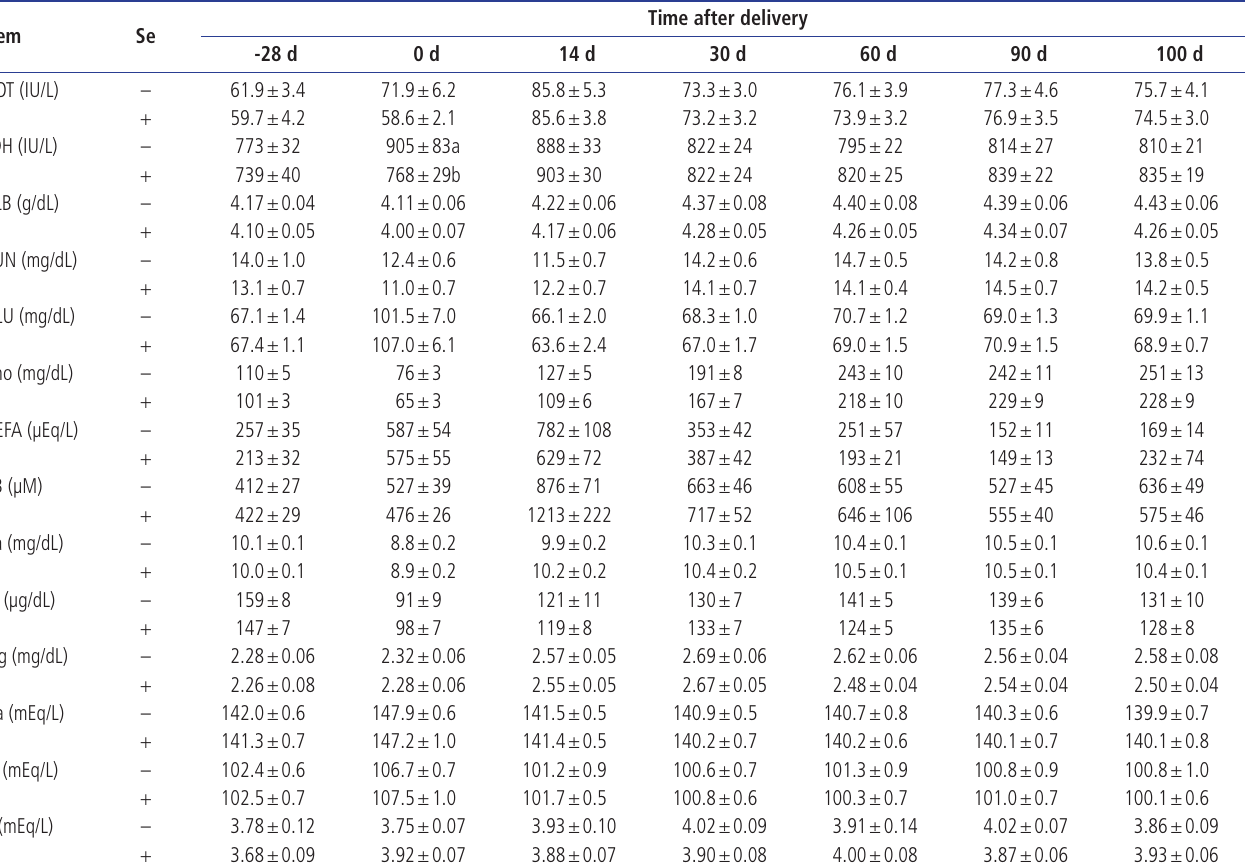
(mean±standard error of the mean; -Se: n = 17, +Se: n = 17). Blood sampling from the jugular vein was carried out in the morning on –30 d, 0 d, 30 d, 60 d, 90 d, and 100 d after delivery. The Se concentrations of blood plasma was analyzed using an atomic absorption spectrophotometer. Significant difference according to the Bonferroni method was defined as a p value of <0.05 (*).